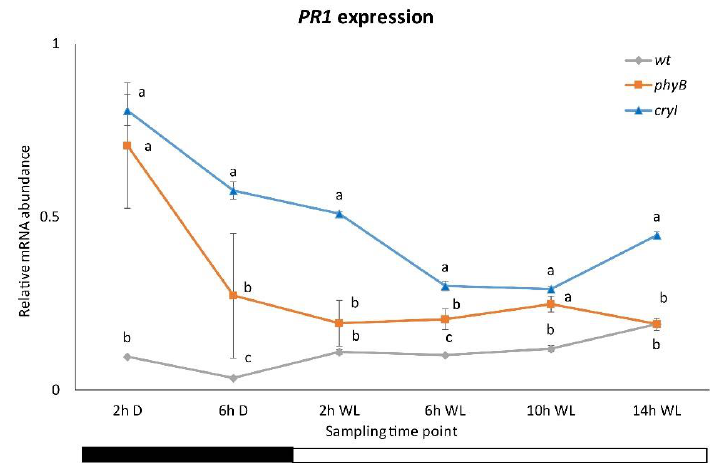
Figure 6. PR1 expression in Dar Gazi-wt , Dar Gazi-phyB , and Dar Gazi-cry1 . Results are presented after normalization with ef1A . Data shown as the average of two biological replicates run in triplicate, with error bars representing SD. At each time point, values with different letters significantly differ according to the analysis of variance (ANOVA) and least significant difference (LSD) tests ( p ≤ 0.05). The bars under the horizontal axis show the light and dark periods. The analysis of PR10 gene expression indicated that, in the plantlets of the three Dar Gazi lines, the overexpression of each photoreceptor gene drastically reduces the amount of transcript detected (Figures 7 and S3). Furthermore, the oscillatory rhythm detect in the plantlets of Dar Gazi-wt results was almost repressed. However, in the overexpressing of PHYB plantlets, expression was maintained in the first 2 h of darkness.